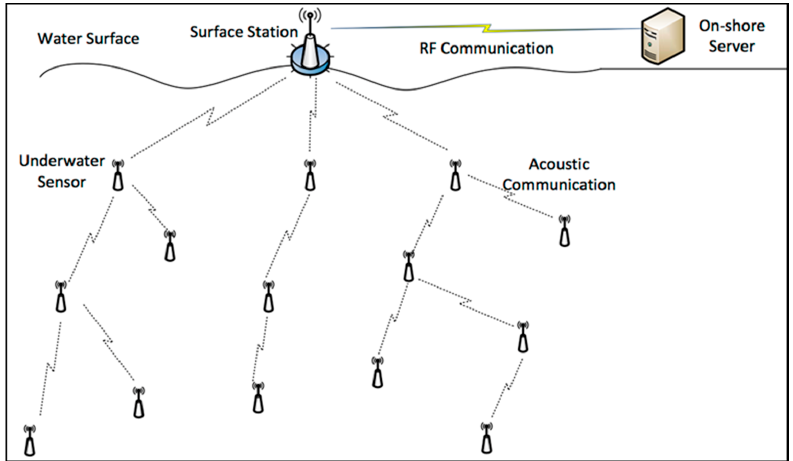
Figure 4. Cooperative multi-hop UASNs.